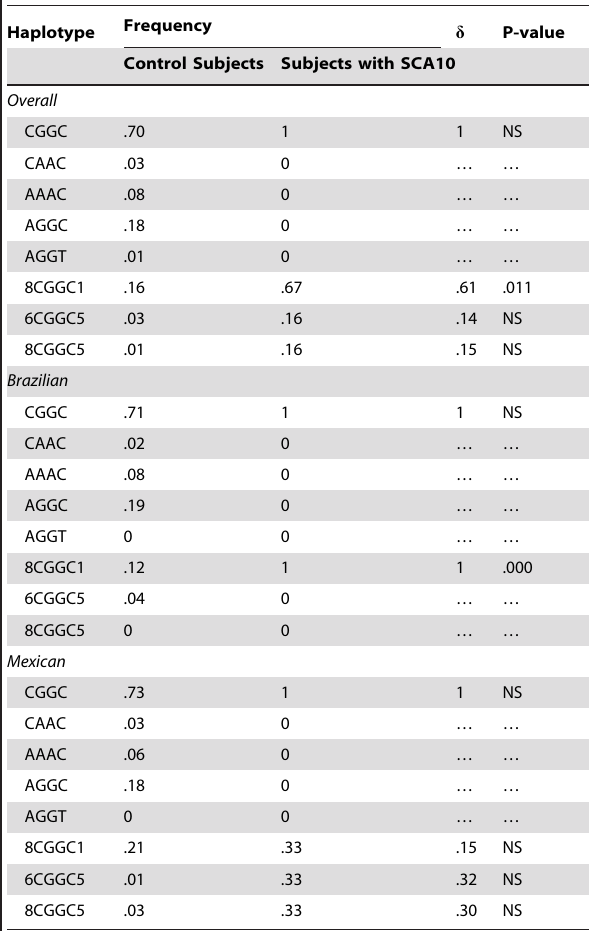
Table 1. Overall and by Population LD Analysis.